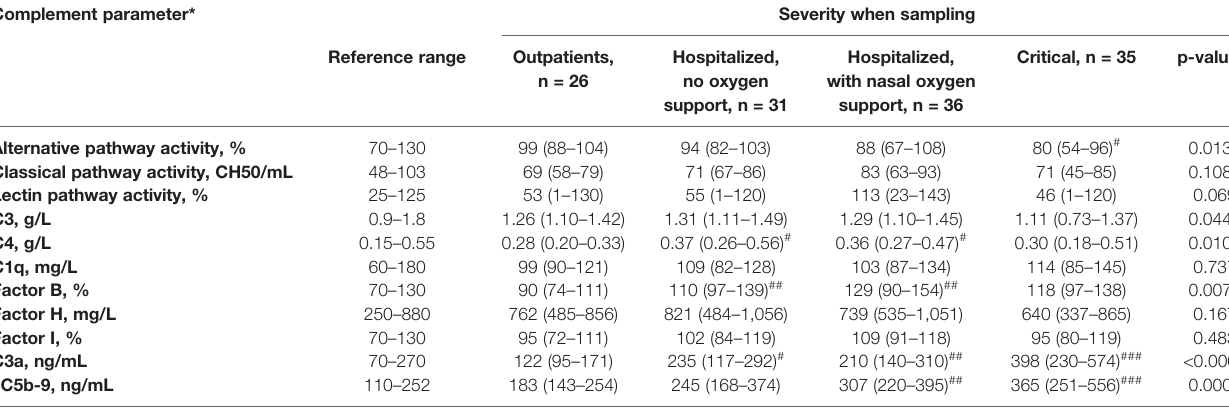
TABLE 2 | Complement pro fi le of the SARS-CoV-2 infected patients, comparison according to severity when sampling. Complement parameter*